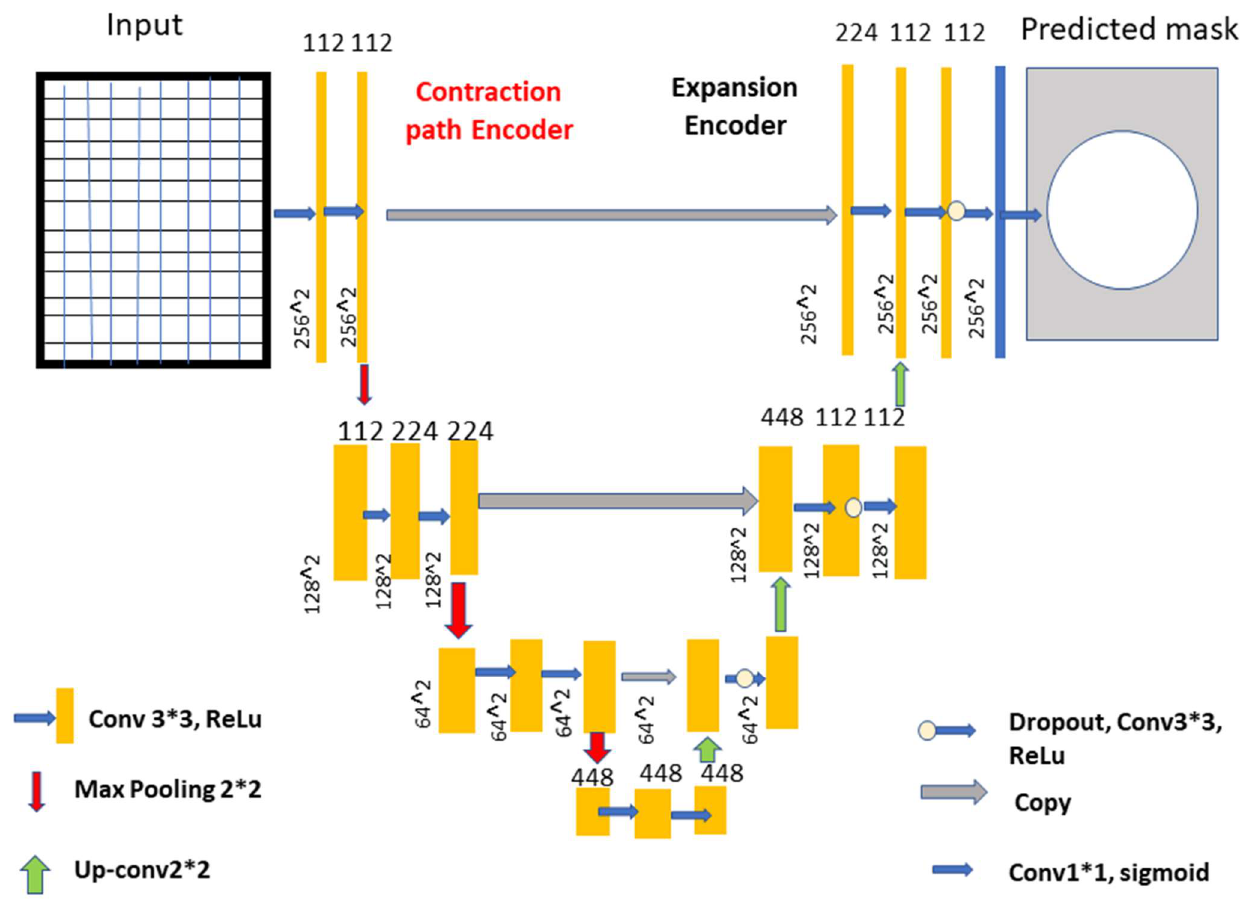
Figure 4. The improved U-Net model. Process see Box 1.